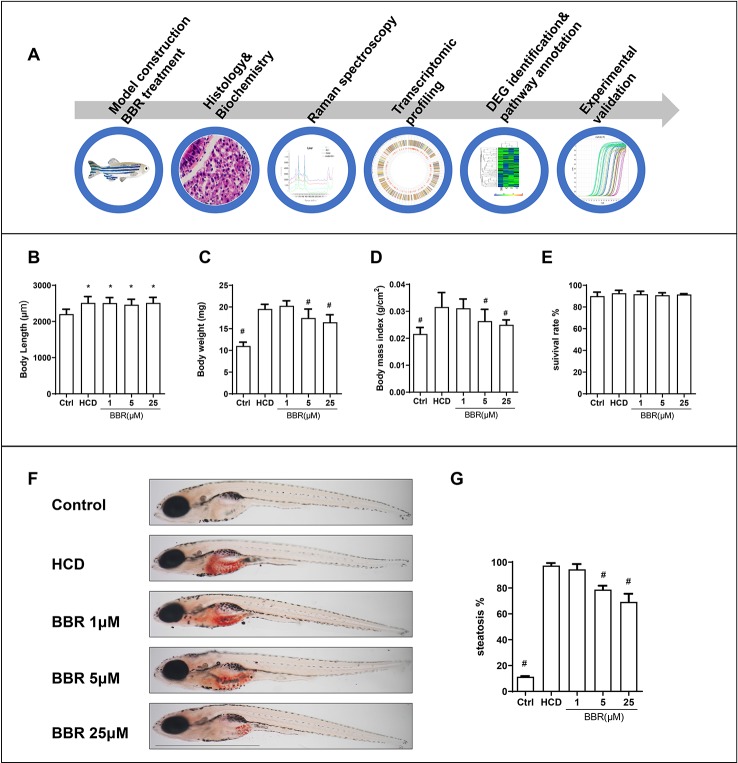
Effects of high-cholesterol diet (HCD) and berberine (BBR) treatment on the growth of zebrafish. (A) Description of the experimental design. (B) Body length, (C) average body weight, and (D) BMI in each group were measured at 15 days post-fertilization (dpf). (E) Larvae with different treatments were scored for mortality. (F) The hepatic steatosis of zebrafish was detected by whole-body Oil Red O (ORO) staining. (G) Percent of larvae with hepatic steatosis. *Compared with the control; #compared with the HCD group, P < 0.05. Bar, 1 mm.